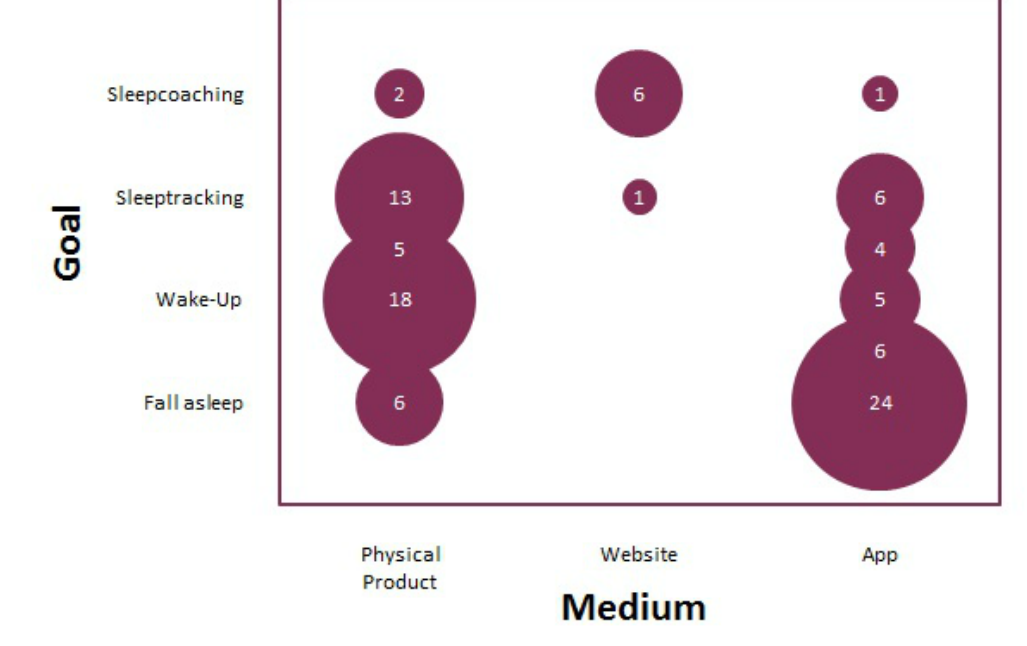
Figure 2. A graph showing the relationship between the goal of sleep products and the medium used. The size of each bubble indicates how many products of the 97 identified sleep products belong to that